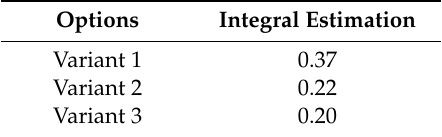
Table 5. estimation of land plot options for gas pipeline